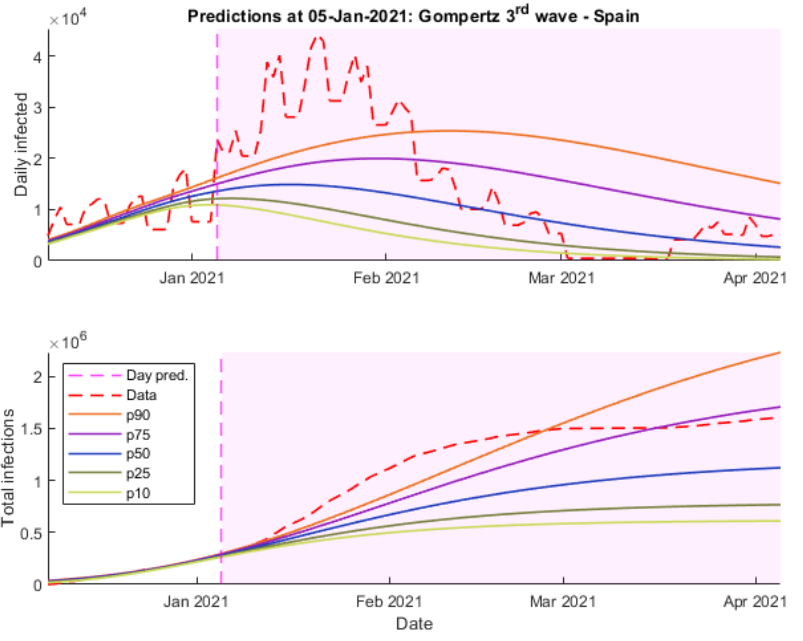
Figure 9. Predictions 5 January 2021 wave 3 Gompertz — Spain.